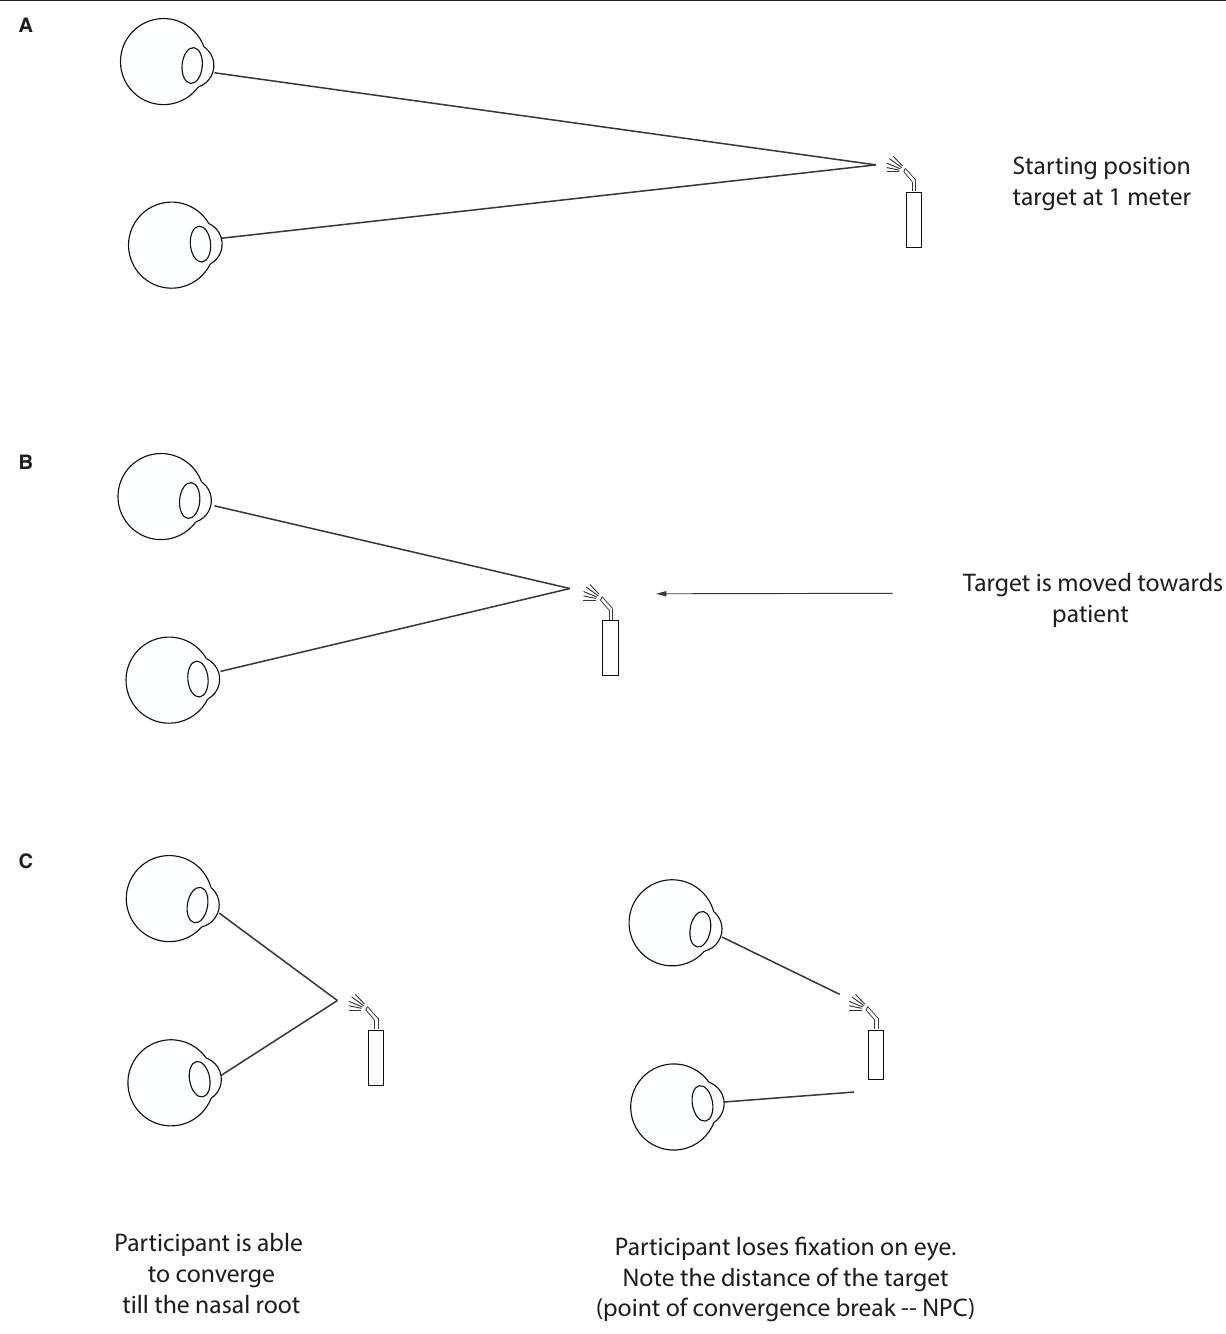
from abnormal visual spatial processing may perceive objects that are in line with their vertical center of their body to be shifted on one side. In their validated BIVSS, Laukkanen et al.